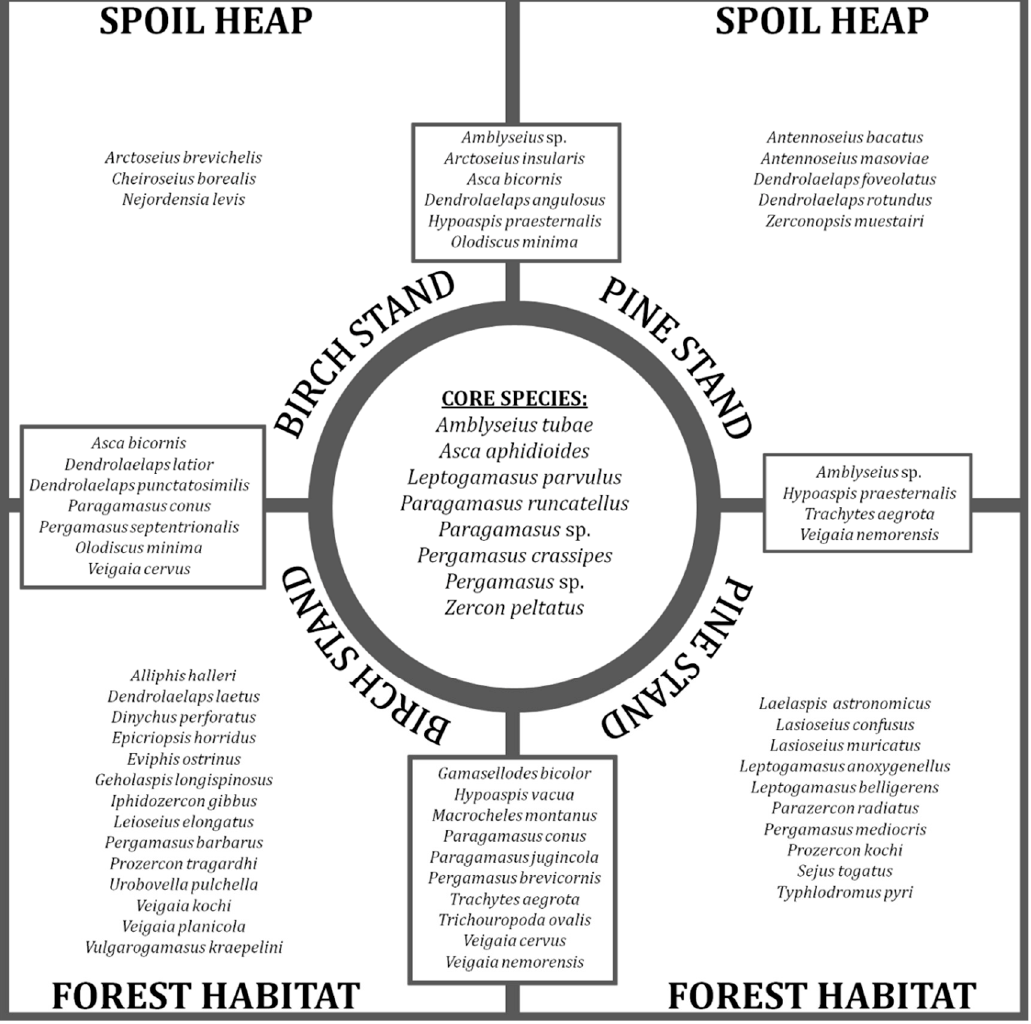
Figure 3. Core, exclusive and common (in frames) mite species in Betula pendula (Bp) and Pinus sylvestris (Ps) stands growing in forest habitat (FH) and spoil heap (SH).